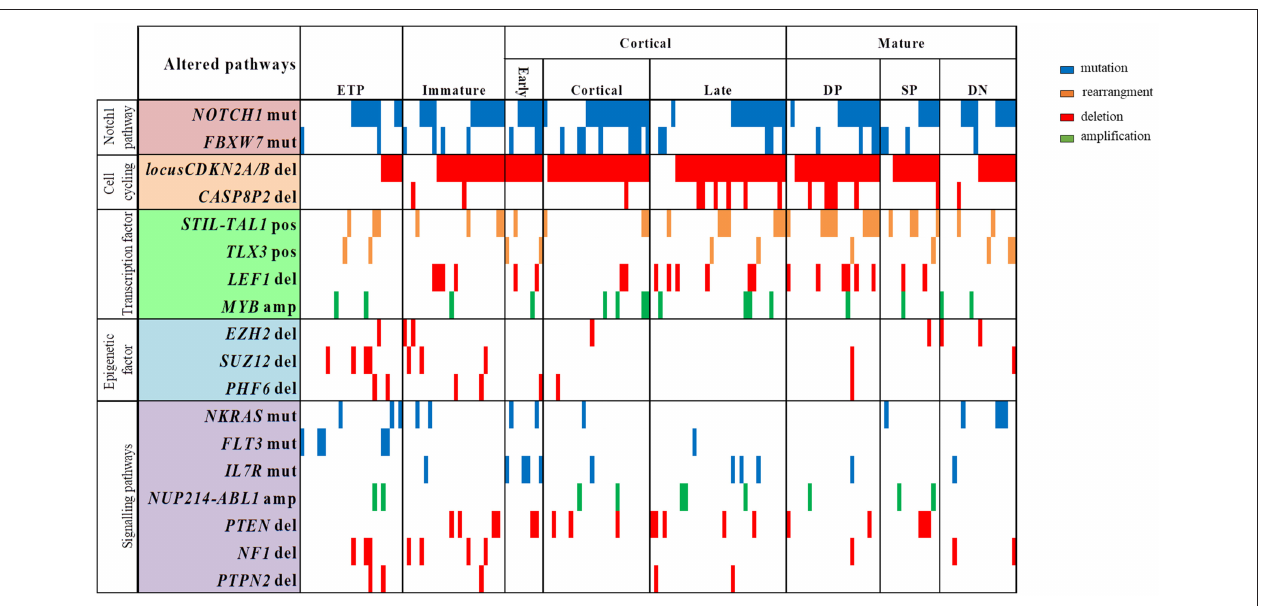
FIGURE 2 | Overview of molecular alterations identified in 168 samples according to T-ALL subtypes and grouped into recurrently altered pathways. ETP, early T cell precursror; DP, douple positive for CD4/CD8; SP, single positive for CD4/CD8; DN, double negative for CD4/CD8; mut, mutation; del, deletion; pos, positive; amp, amplification. Vertical lines represent each